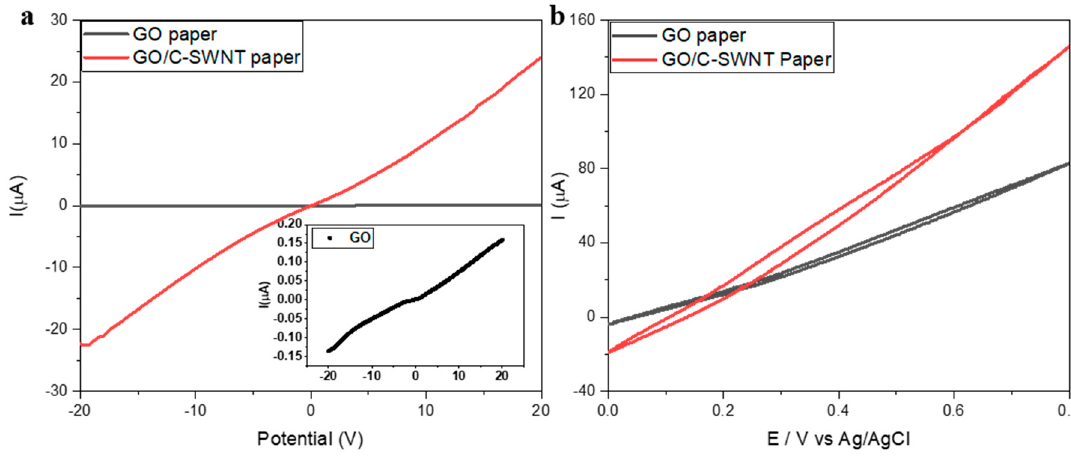
Figure 3. ( a ) I-V curve of GO-paper and GO/C-SWNT paper between − 20 to 20 V. Inset shows resolved I-V curve from GO-paper. ( b ) Cyclic voltammetry for GO and GO/C-SWNT paper in buffer solution (PBS = 7).